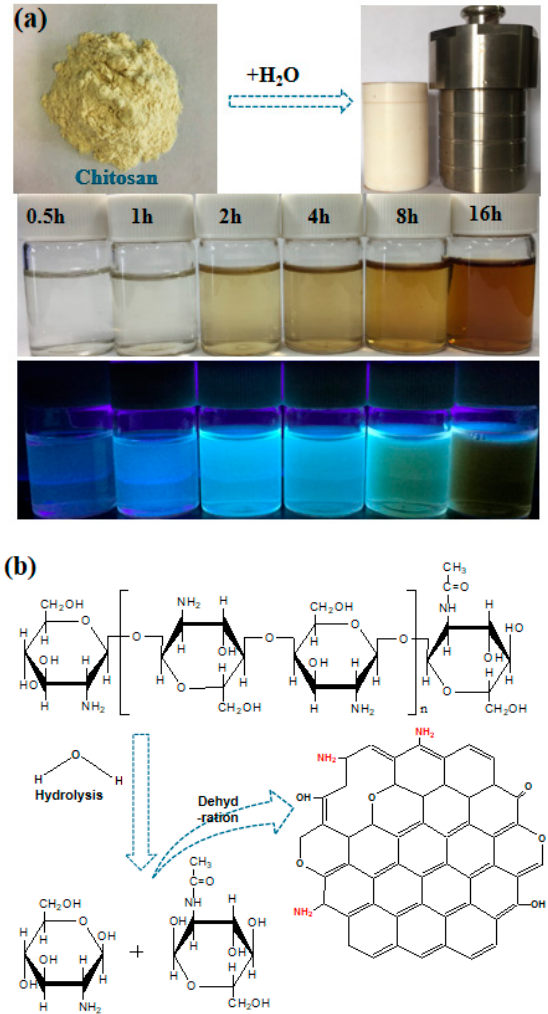
Figure 1. ( a ) Conversion processes from chitosan powders to carbon quantum dots (CQDs) by a hydrothermal method and images of nitrogen-doped carbon quantum dots (N-CQDs) aqueous solutions synthesized at different heating times under UV light irradiation. ( b ) Synthesis strategies of N-CQDs from chitosan.